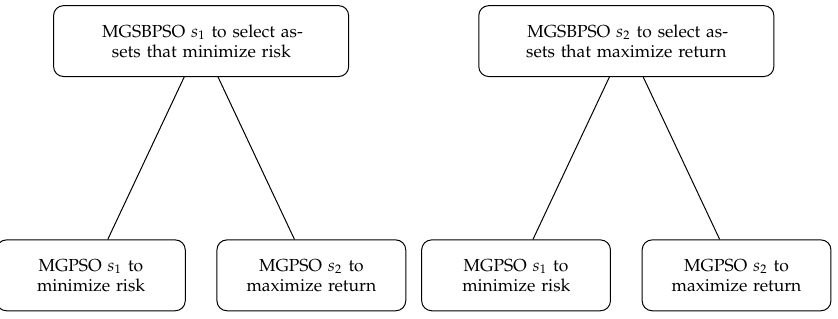
Figure 2. MGSBPSO structure.